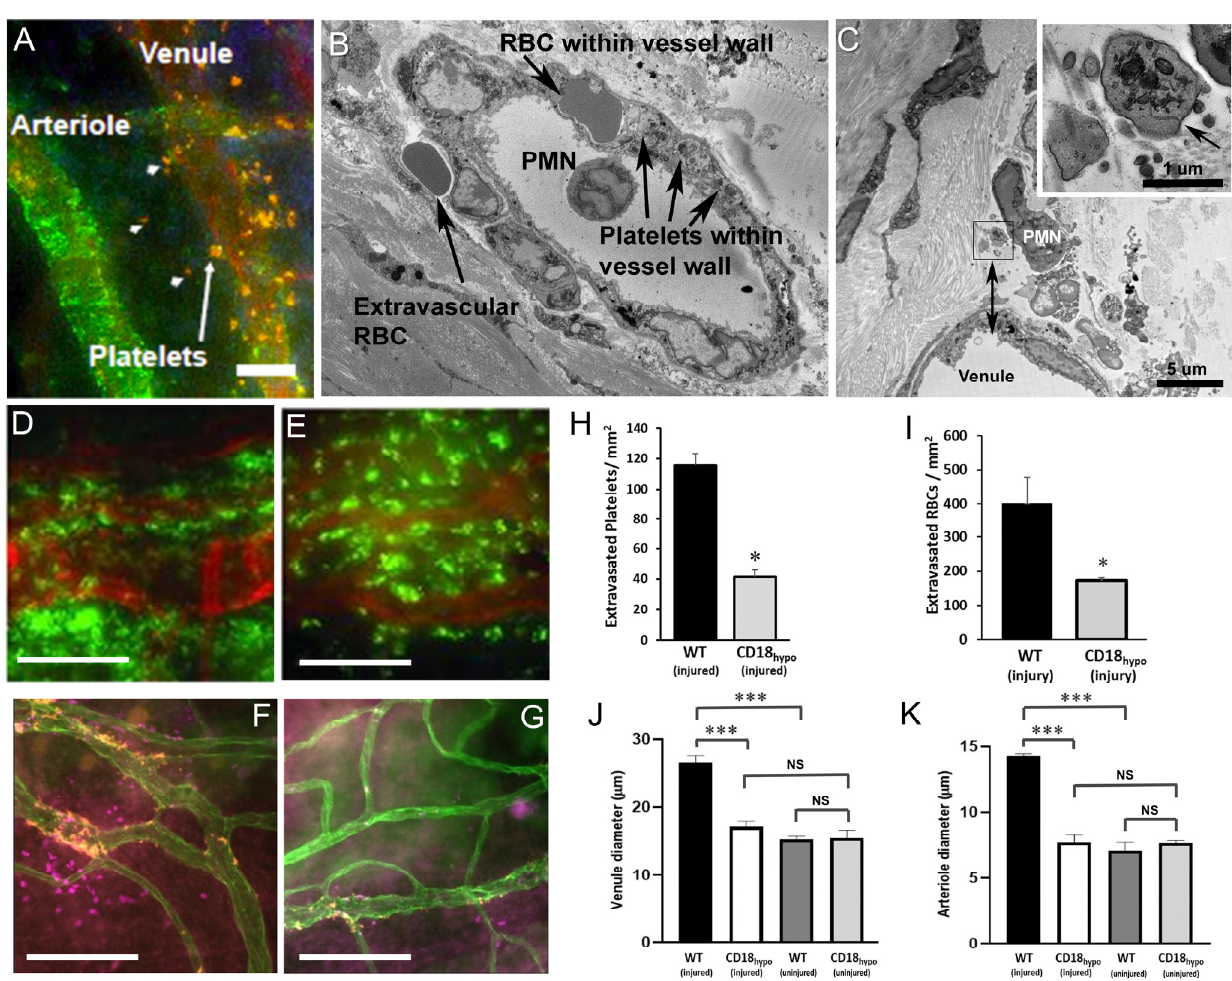
Figure 1. Blood cell extravasation after corneal abrasion in wild-type (WT) and CD18 hypomorphic (CD18 hypo ) mutant mice. Images of abraded corneas of WT ( A – E ) and CD18 hypo mice ( F – G ) at 8 h after epithelial abrasion. ( A ) Immunostaining (orange, anti-CD41) showing platelet extravasation from limbal vessels (arrowheads, extravascular platelets; arrow, platelets within the venule wall). A nearby arteriole identified by positive labeling for smooth muscle alpha-actin (green) showed no evidence of platelet extravasation. ( B ) Electron micrograph of an inflamed limbal venule showing an red blood cell (RBC) and several platelets beneath the endothelium but still within the venule wall. One extravascular RBC is located just outside the wall. ( C ) Electron micrograph showing an extravascular neutrophil (PMN) and several extravascular platelets next to a venule. The extravascular platelets are within the inset box immediately to the left of the PMN and the lower edge of the inset box is positioned 6 µm from the luminal endothelial surface of the venule (see double arrowhead). An enlarged view of the inset (upper right) shows an extravascular platelet positively identified by a surface-connected canaliculus (arrow). A second extravascular platelet (identity confirmed by serial sections not shown) is located to the lower left. ( D , E ) Immunofluorescence images from a WT mouse ( D ) and a CD18 hypo mouse ( E ) with large numbers of extravascular PMNs (green, anti-Ly6G) adjacent to limbal vessels (red, anti-CD31). ( F , G ) Immunofluorescence images show extravascular platelets (orange, anti-CD41) and extravascular RBCs (magenta, anti-TER119) adjacent to limbal vessels (green, anti-CD31) in a WT mouse ( F ) but absent from the CD18 hypo mouse ( G ). ( H ) Data showing extravascular platelet and ( I ) RBC counts at 24 h post-injury along with diameters of limbal venules ( J ) and arterioles ( K ) before and 24 h after epithelial abrasion ( n = 6 mice per group, NS = Not Significant, * p ≤ 0.05 and *** p ≤ 0.001). Unlabeled scale bars = 15 µm ( A ); 10 µm ( B ); 50 µm ( D , E ); 100 µm ( F , G ).